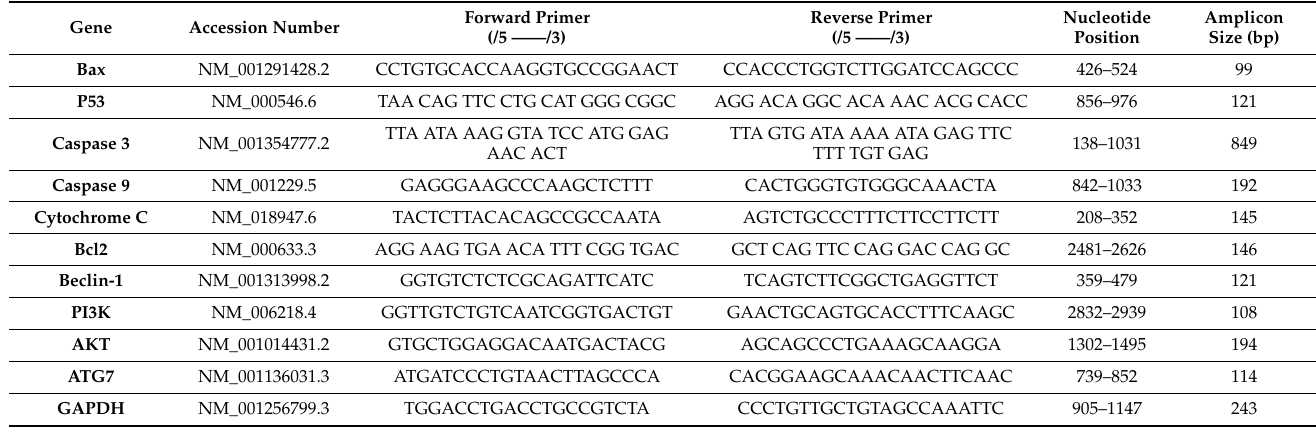
Table 4. Human primers sequences used in real-time PCR.